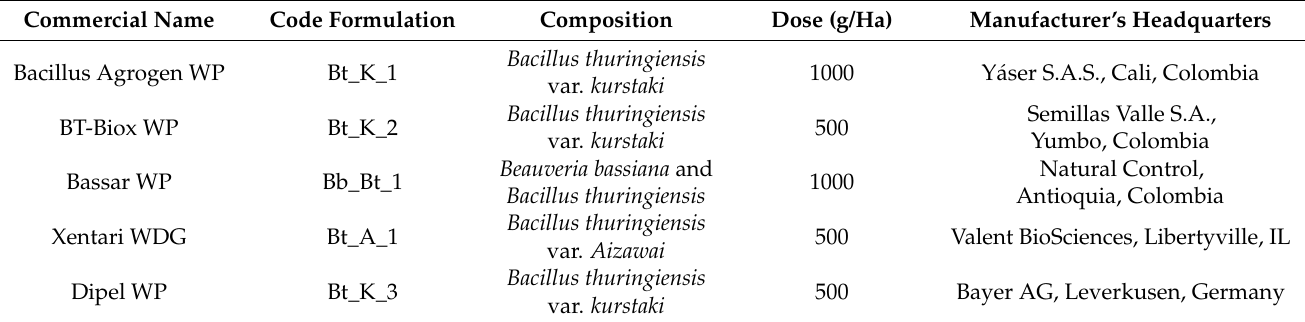
Table 1. Bacillus thuringiensis commercial formulations were evaluated to control Stenoma impressella larvae under laboratory conditions (i.e., 26.8 ± 0.4 ◦ C and 73.7 ± 9.2% relative